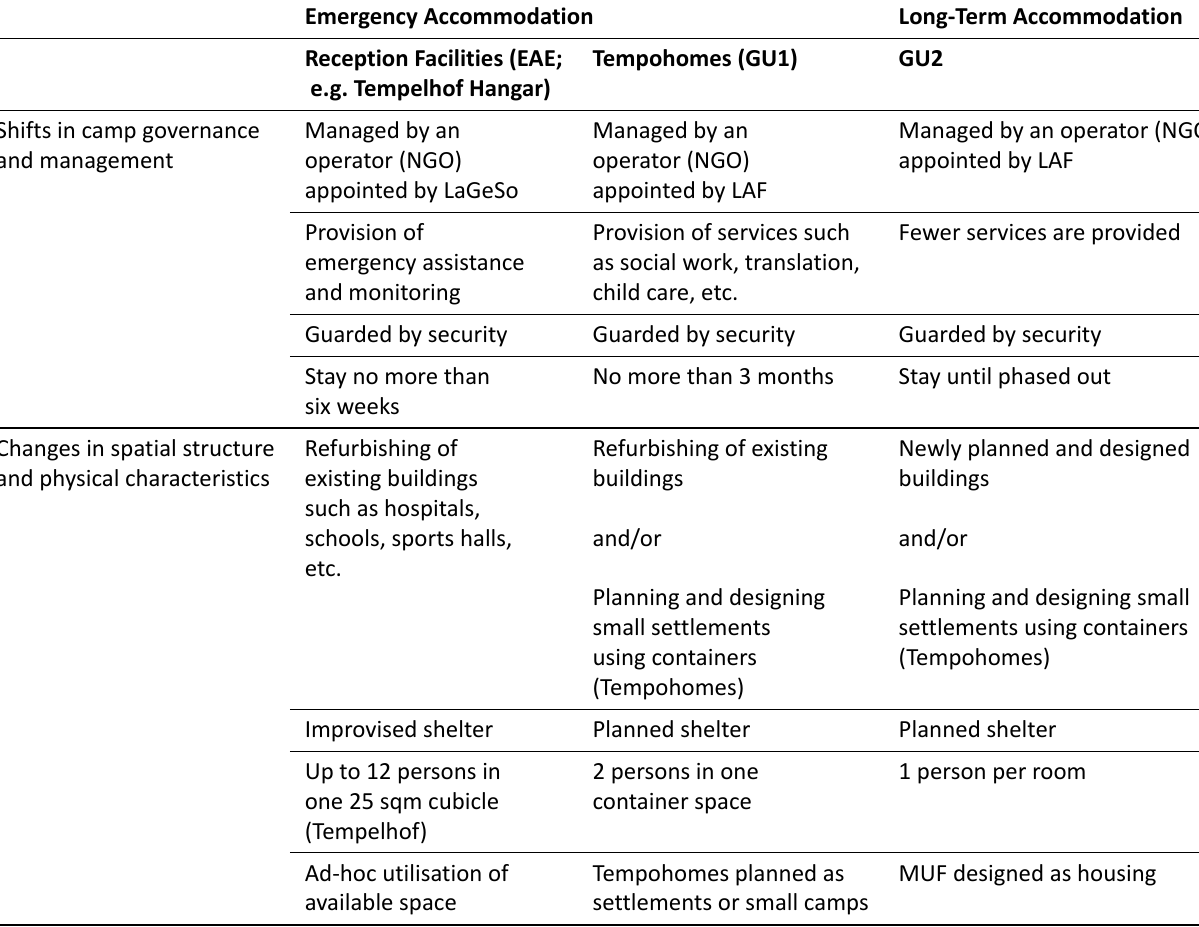
Table 2. Managerial and physical characteristics of refugee accommodations in